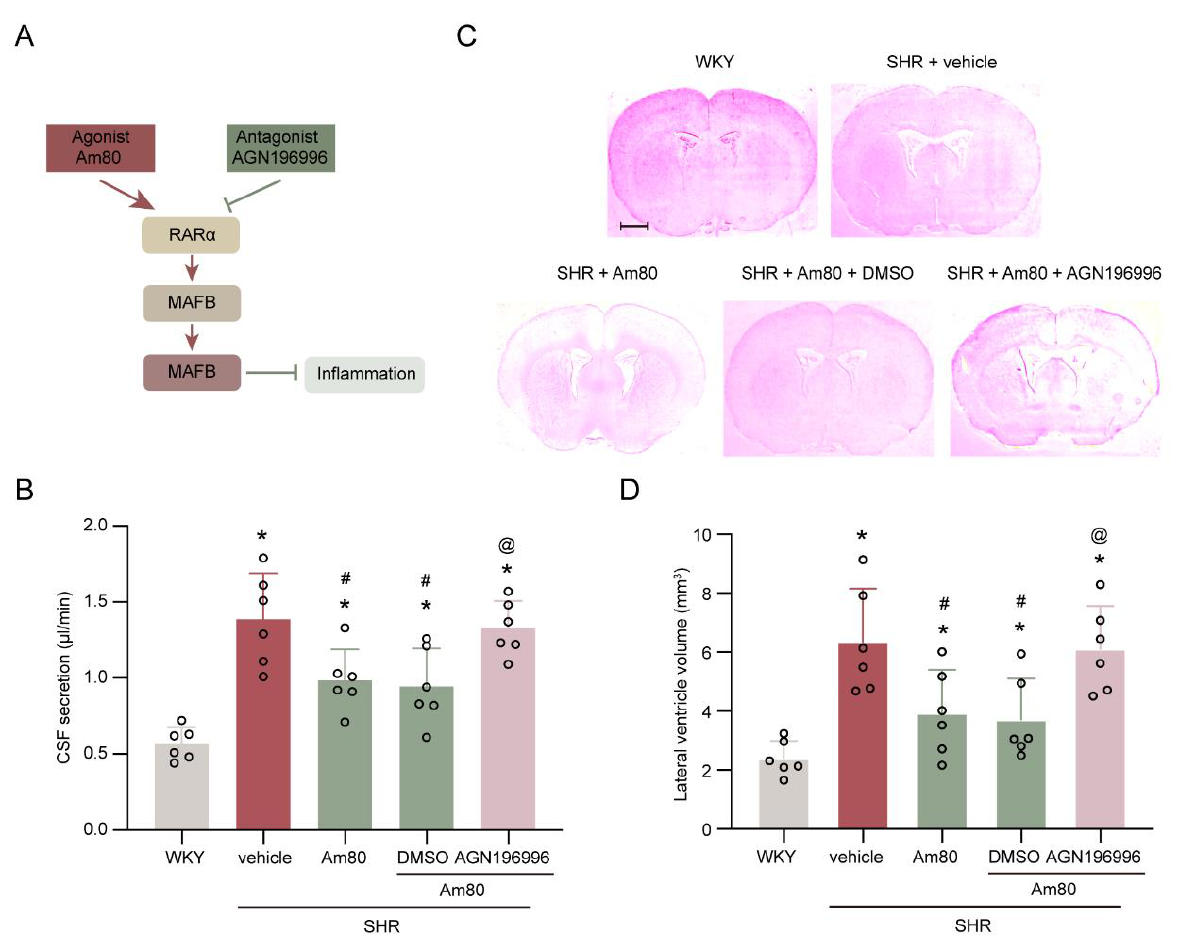
Figure 3. AGN196996 abolished the protective effects of Am80. ( A ) Schematic diagram of the experimental design. ( B ) Quantification of the rate of CSF secretion at week 7 ( n = 6). ( C ) Representative photomicrographs of coronal sections of rat brains (at − 0.6 mm from the bregma), depicting ventricular volume at week 7. Scale bar, 2 mm. ( D ) Quantification of lateral ventricle volume at week 7 ( n = 6). * p < 0.05 versus WKY rats at week 7, # p < 0.05 vs. SHR + vehicle group, @ p < 0.05 vs. SHR + Am80 + DMSO group. Values are means ±